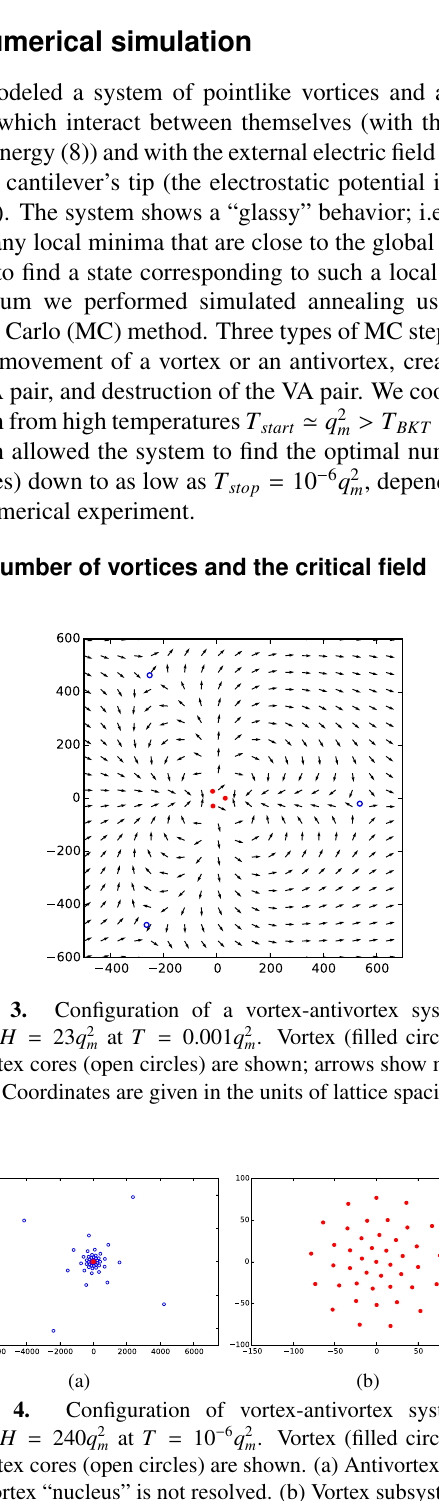
Figure 2. Schematic plot for rn ( r ) vs r ; n ( r ) is given by (16).